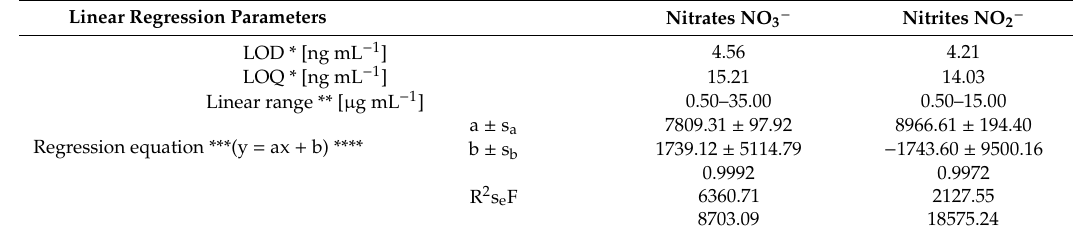
Table 1. The linear regression parameters obtained for the calibration curves of nitrates and nitrites. Linear Regression Parameters